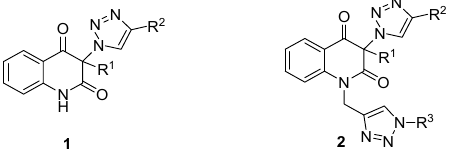
Figure 1. A general structure of 1,2,3-triazole quinoline-2,4-diones 1 ( left ) and the bis(1,2,3-triazole) counterparts 2 ( right ).